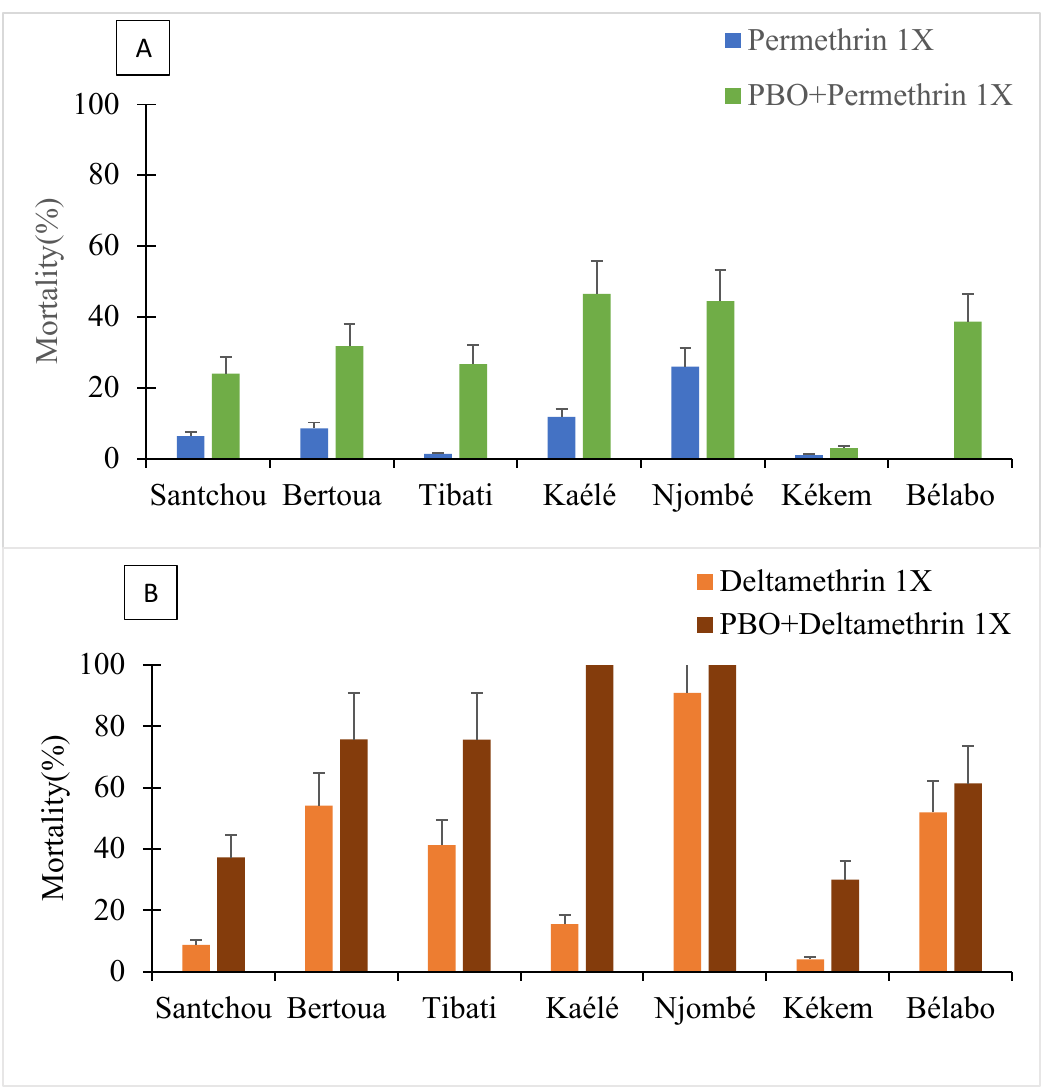
Figure 4. Mortality rate of An. gambiae s.l. after synergist assays with permethrin ( A ) and deltamethrin ( B ).